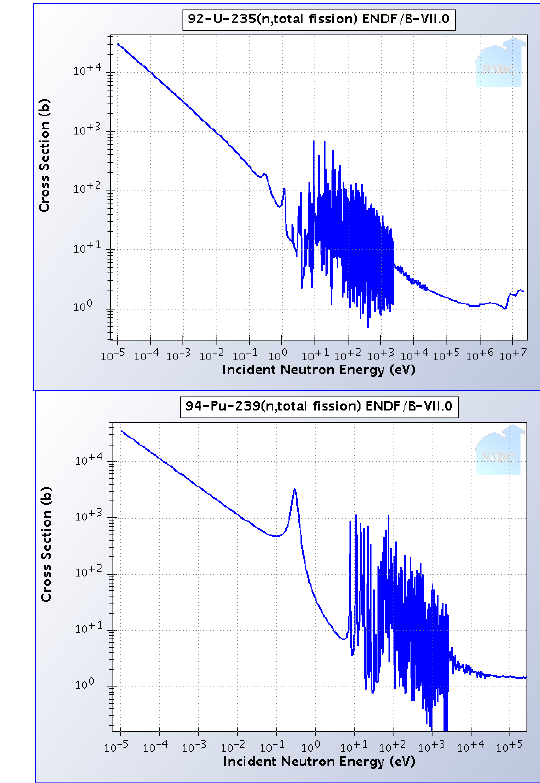
Figure 31. Fission cross sections for U-233, U-235, U-238 and Pu-239. U-233, U-235 and Pu-239 have high fission cross-sections for thermal neutrons and low fission cross–sections for fast neutrons. The opposite is true for U-238. Retrieved from National Nuclear Data Centre